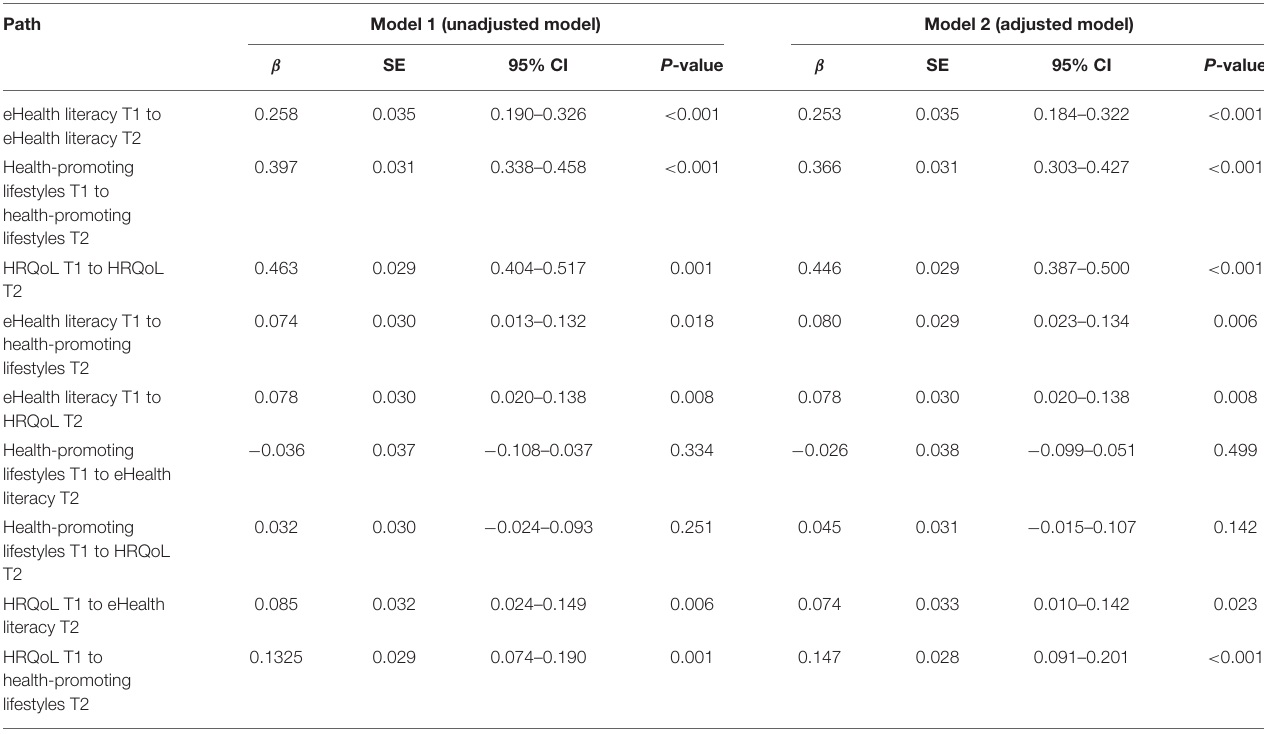
TABLE 3 | Bootstrapped estimation of each path of the cross-lagged